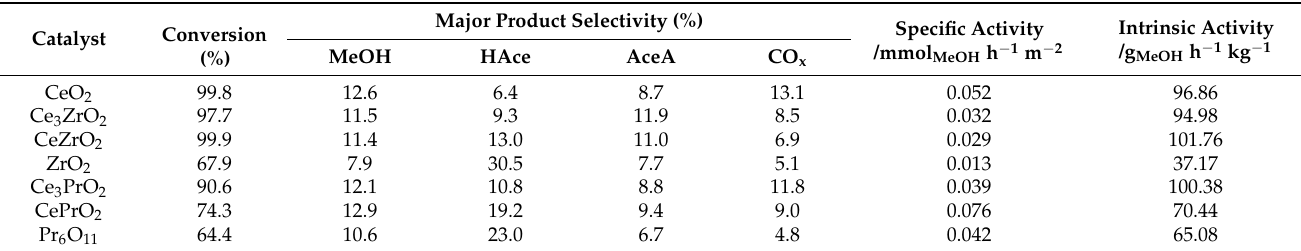
Table 2. Activity of Ce-Zr and Ce-Pr solid solutions. Data reproduced from ref. [58] with permission from the Royal